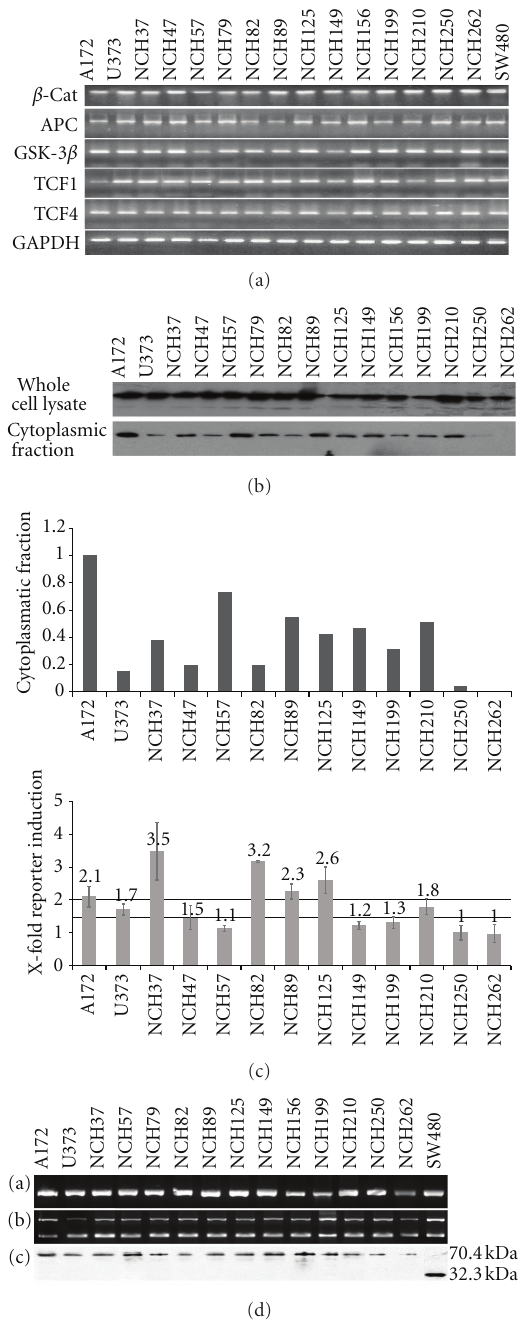
Figure 1: (a) Gel electrophoresis showing expression of key players of the canonical wnt signalling pathway as assessed by RT-PCR. (b) (upper rows) Representative western blot analysis of 3 independent experiments displaying β -catenin expression in whole cell lysates and corresponding cytoplasmic fractions of high-grade glioma cultures. (lower graph) Quantification of the cytoplasmatic β -catenin fractions shown in (b). Expression levels were normalized to A172. (c) Transcriptional activity of β -catenin in glioma cultures as assessed by TOPFLASH/FOPFLASH reporter gene assay. Ordinate shows x-fold induction of the luciferase reporter gene in comparison to the control vector (FOPFLASH). Horizontal lines mark 1.5-fold and 2-fold reporter induction, respectively. Data indicate mean values of at least 3 independent experiments plus SD. (d) For theAPC truncation test, APC cDNA was amplified in five fragments and subsequently transcribed and translated in vitro . Products were separated by SDS-PAGE, blotted on a PVDF membrane, and stained with streptavidin peroxidase. No truncating mutations were found in any of the glioma cultures. Here, cDNA amplification (a), in vitro transcription (b) and in vitro translation (c) of fragment 3 that contains the mutation cluster region are shown. The colon cancer cell line SW480, which contains a homozygous truncating mutation at codon 1338, served as positive control. The molecular weight of the resulting protein fragment in this cell line is thereby reduced from about 70kDa (full-length fragment 3) to 32